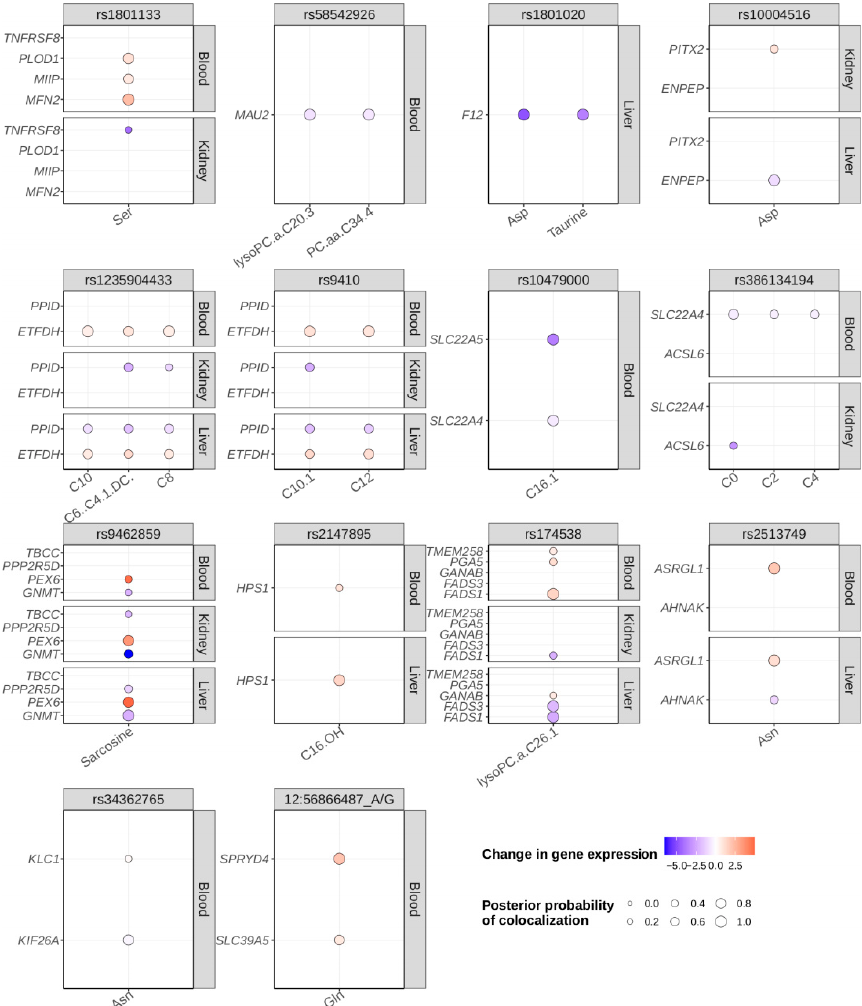
Figure 4. Results of the colocalization analysis. For each index variant with at least one gene colocalized at a posterior probability (PP) ≥ 0.8 in at least one of the three tissues whole blood (Blood), kidney cortex (Kidney), or liver (Liver), colocalization data of all protein coding genes and traits with PP ≥ 0.3 are displayed. The colors represent the change in gene expression relative to an increase in the colocalized metabolite